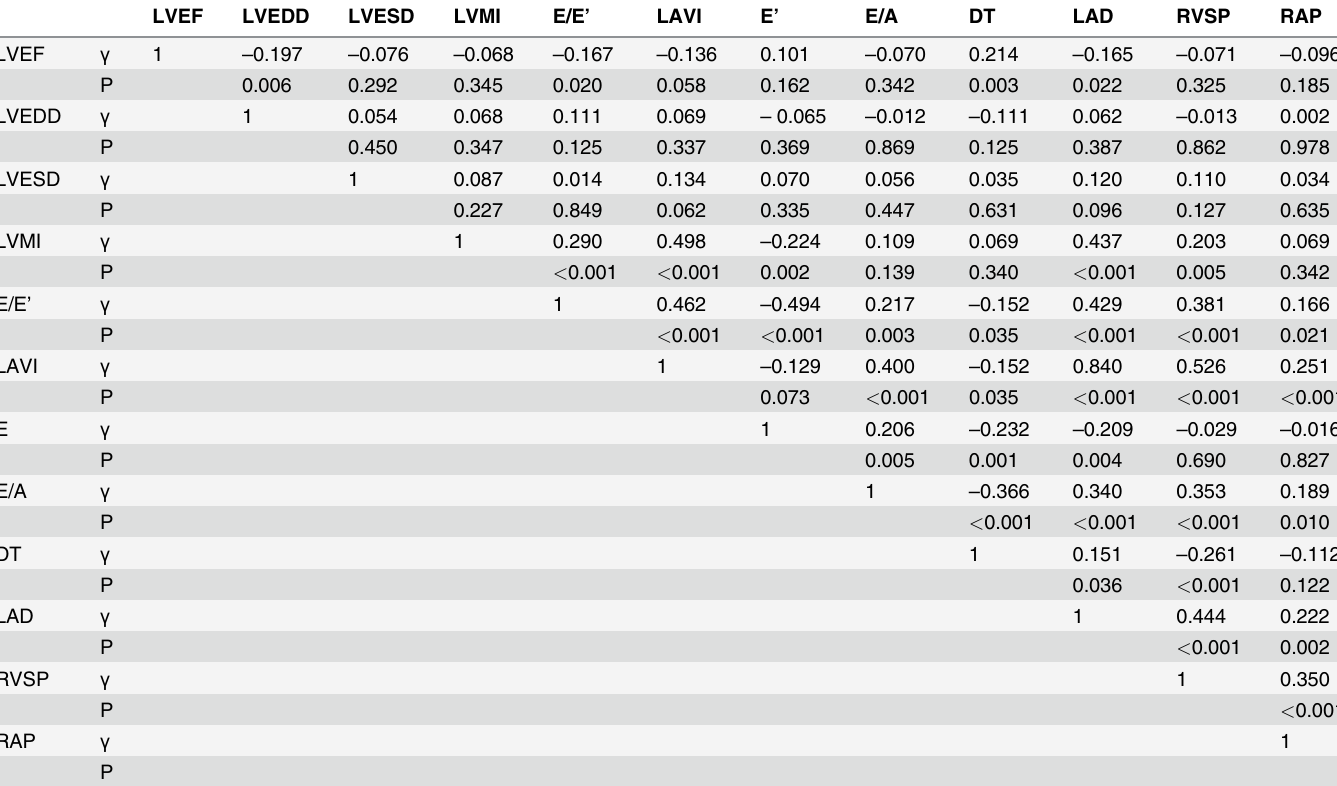
Table 4. Correlations of E/E ’ and LAVI with other echocardiographic parameters.